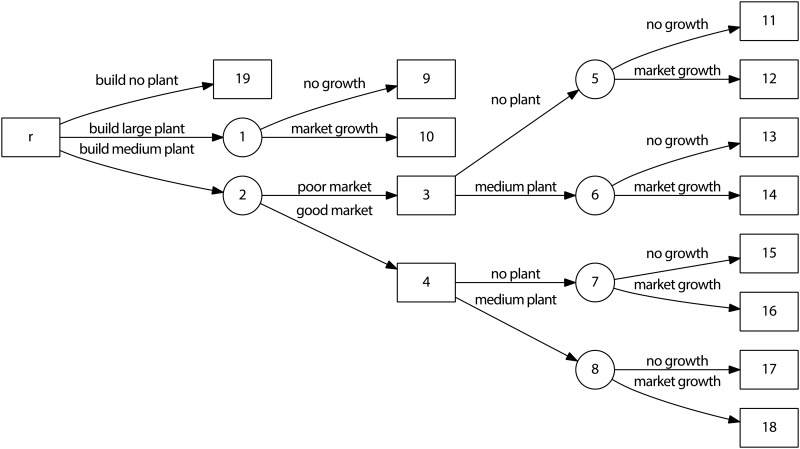
Decision Tree (Source: edited by [57]).